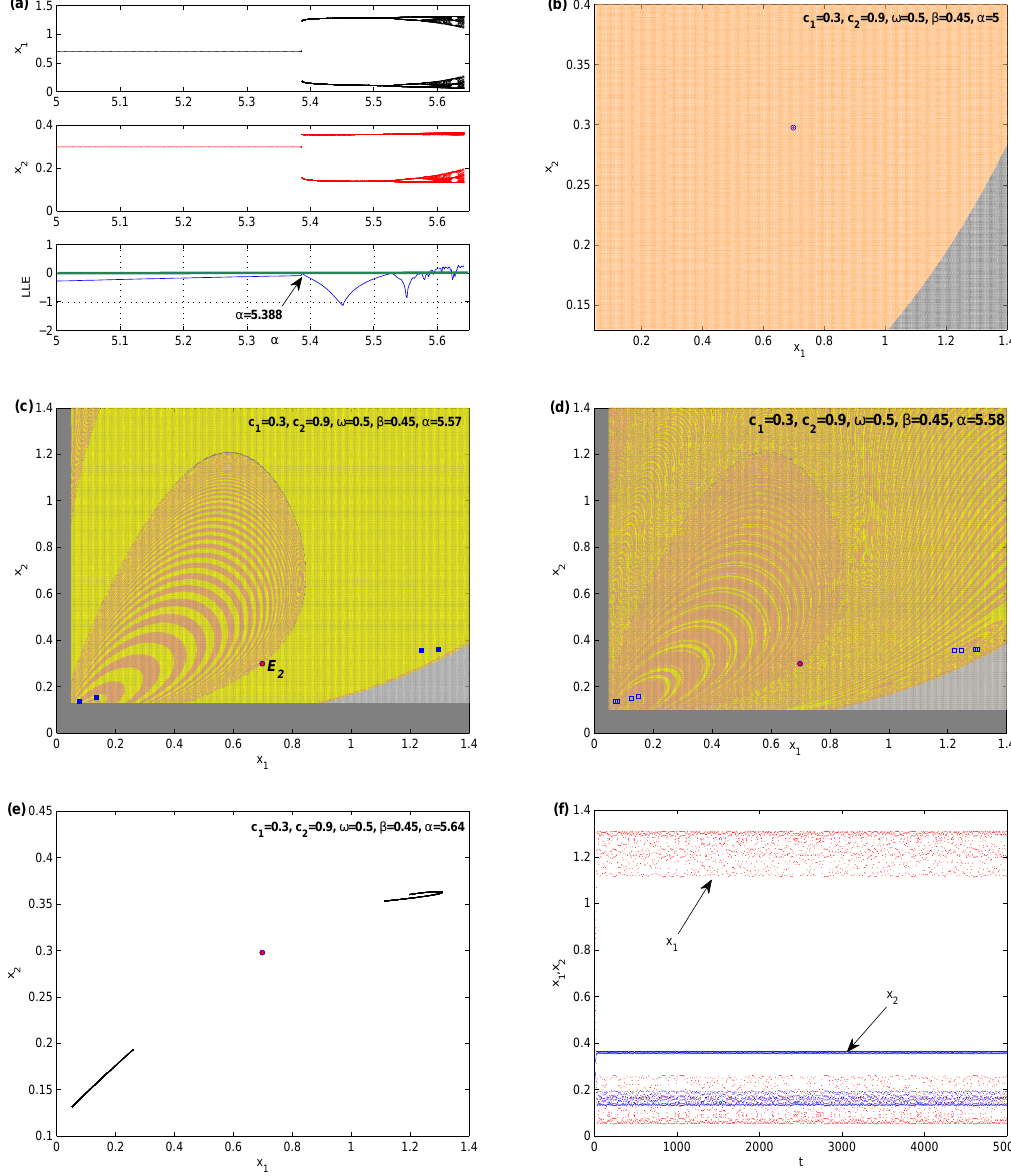
Figure 1. ( a ) Period doubling bifurcation and Lyapunov exponent with respect to α ; ( b ) Basins of attraction of the point E 2 ; ( c ) Basins of attraction of period 4-cycle; ( d ) Basins of attraction of period 8-cycle; ( e ) Phase plane for two chaotic attractors; ( f ) Time series for the decision variables. Other parameters values are c 1 = 0.3, c 2 = 0.9, ω = 0.5 and β =